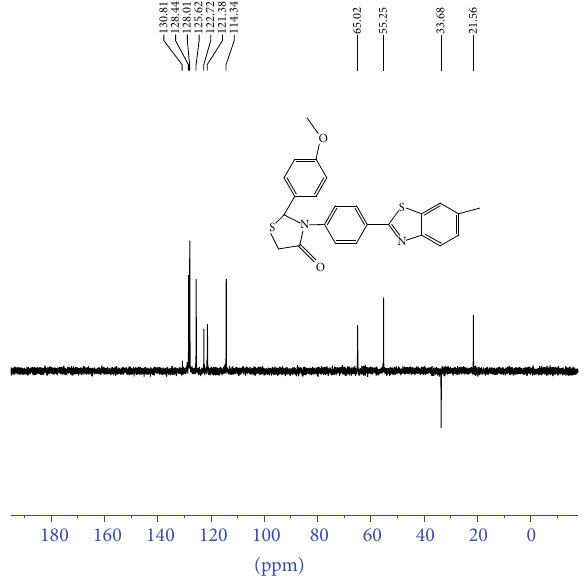
F 6: Dept-135 spectrum of compound